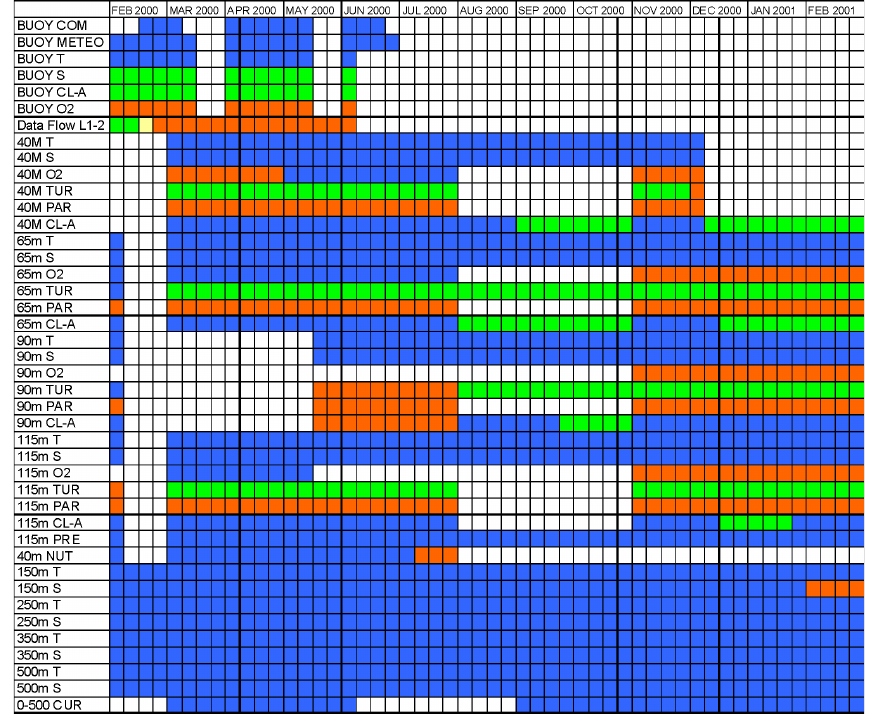
Fig. 5. Weekly performance of the vari- ous system components during the Pilot Phase of MFS. Colors indicate the qual- ity of data, based on comparison against reference measurements. Blue: no need for calibration. Green: data were cal- ibrated. Red: data could not be cali- brated. White: no sensor during that